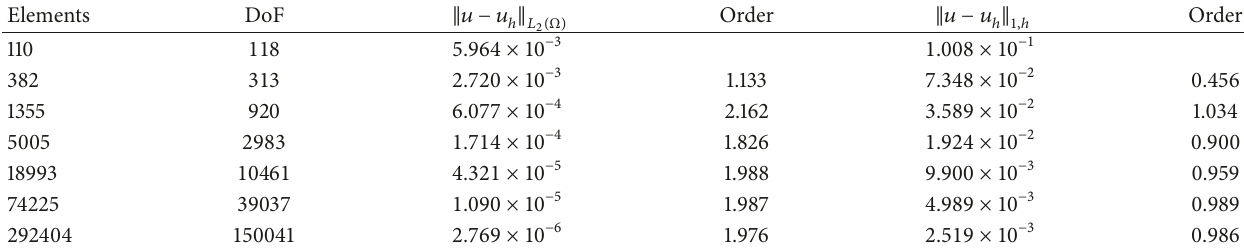
Table 2: 𝐿 2 and 𝐻 1 errors of Example